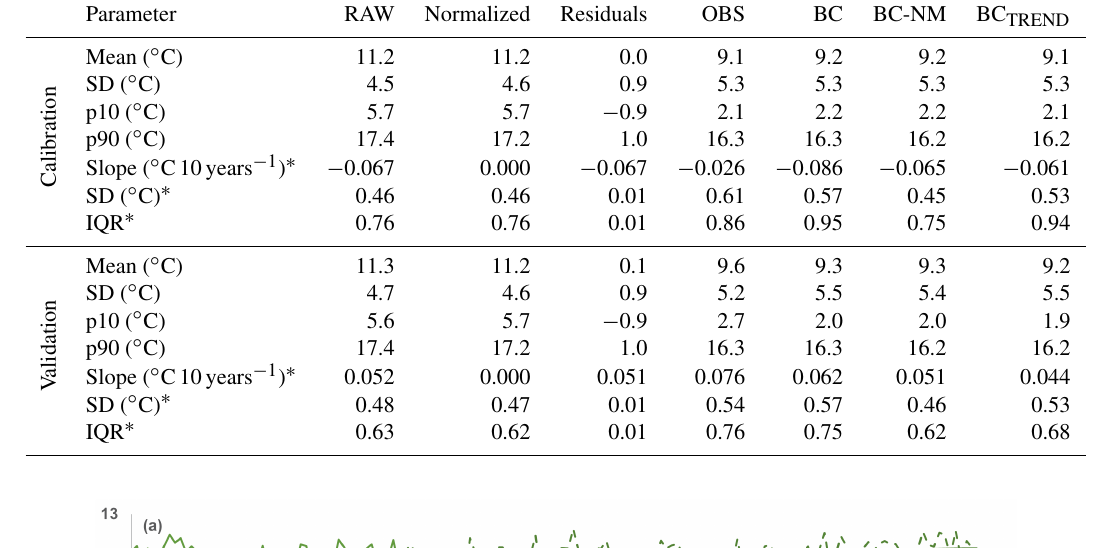
Table 2. Statistical properties of the calibration and the validation periods for the two bias correction procedures. Variables denoted with ∗ are estimated on annual aggregates. SD stands for standard deviation, p n for the n th quantile and IQR for the interquartile range.